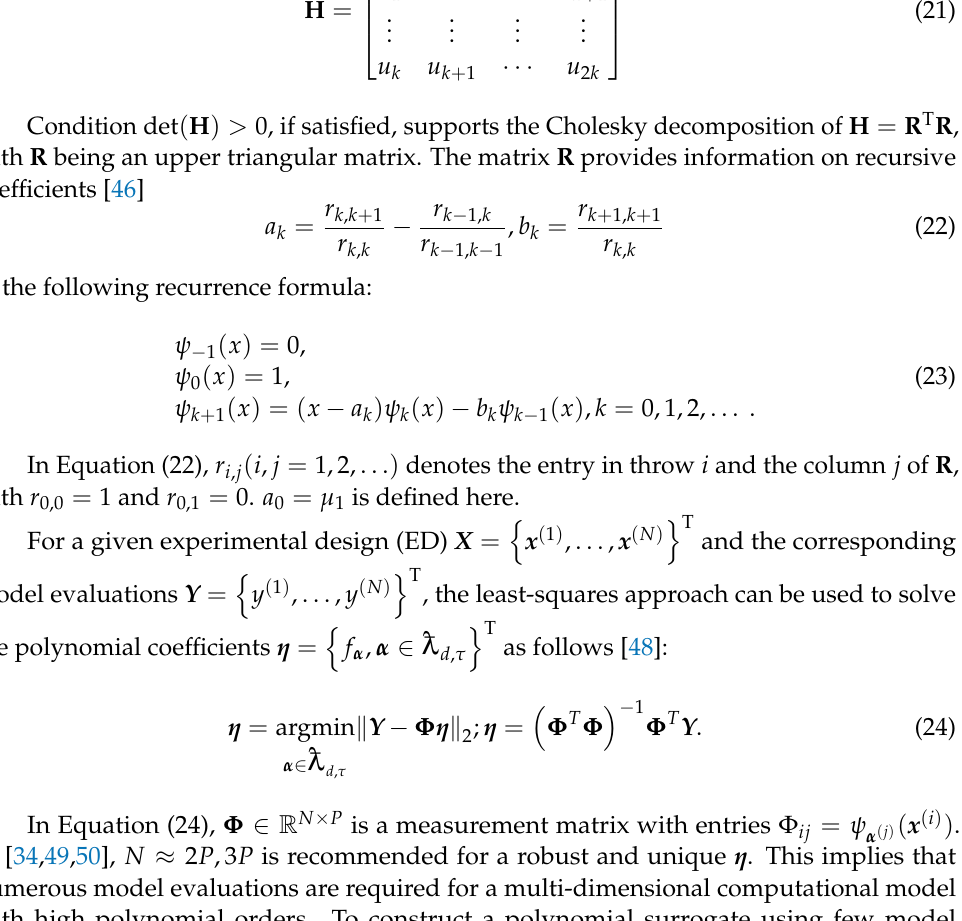
Figure 2. Framework of the SSR-ETM and ETM.